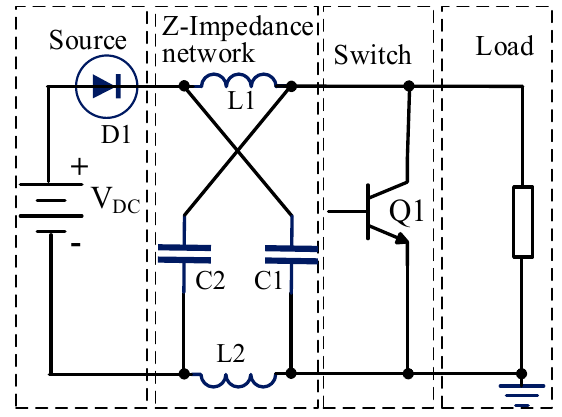
Figure 5. Electrical diagram of Z-source converter. The Z-source converter, similar to the ZSI, operates on the same principles as the NST (Non-Shoot-Through) and ST (Shoot-Through) switching states.